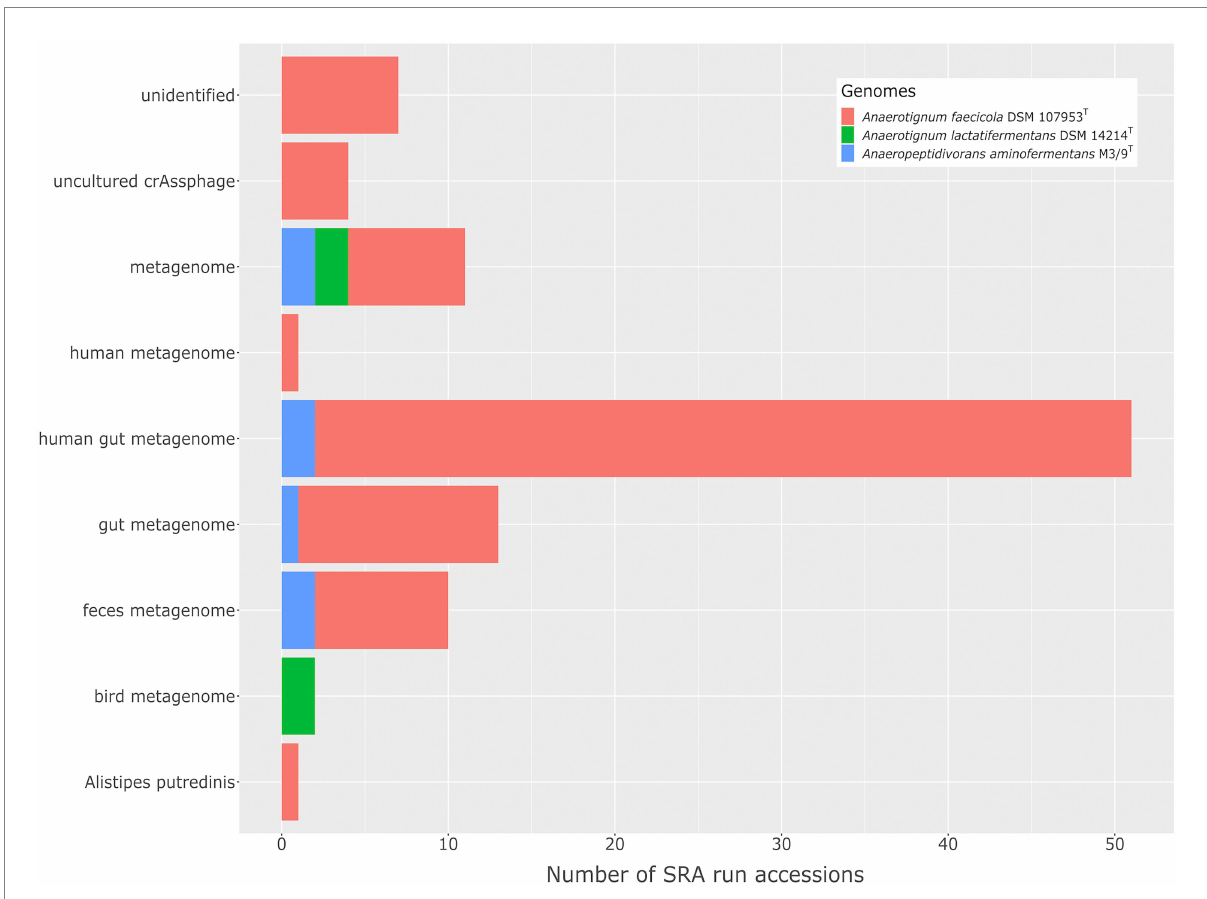
FIGURE 6 The distribution of A. aminofermentans M3/9 T and closely related Anaerotignum species in different environments as deduced from metagenome fragment